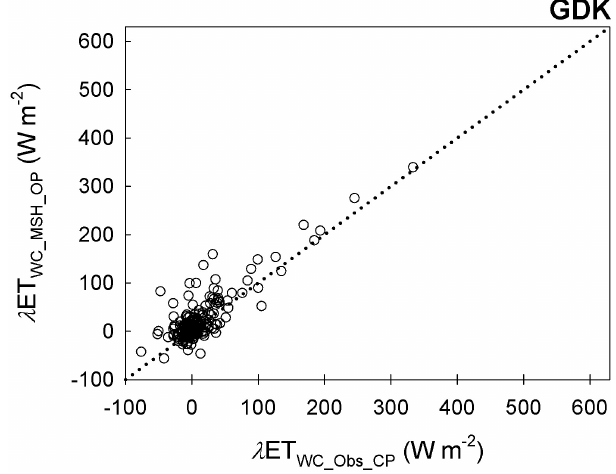
Figure C1. Comparison of the latent heat flux under (mostly) wet canopy conditions (i.e., W c /S > 2 / 3, where W c is the intercepted canopy water and S is the canopy storage capacity) at the GDK site: λ ET WC_Obs_CP indicates the observed latent heat flux under wet canopy conditions (λ ET WC ) from a closed-path eddy covari- ance (EC) system, while λ ET WC_MSH_OP indicates the estimated λ ET WC from an open-path EC system using the MSH method. The dotted line represents the 1 : 1